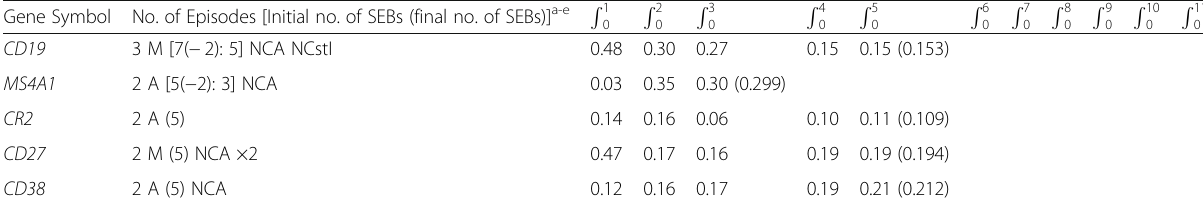
Table 8 (+) strand chromatin CD19 , MSA1 , CR2 , CD27 and CD38 cluster of differentiation receptor gene sequential esebssiwaagoT Q s to final 2-digit (and 3-digit) esebssiwaagoT Q Gene Symbol No. of Episodes [Initial no. of SEBs (final no. of SEBs)] a-e